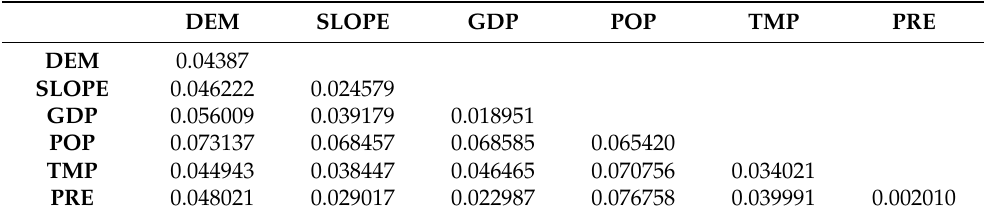
Table A7. The force (q-value) among any two influencing factors on Splitting Index (SPLIT) interac- tively in 1990.